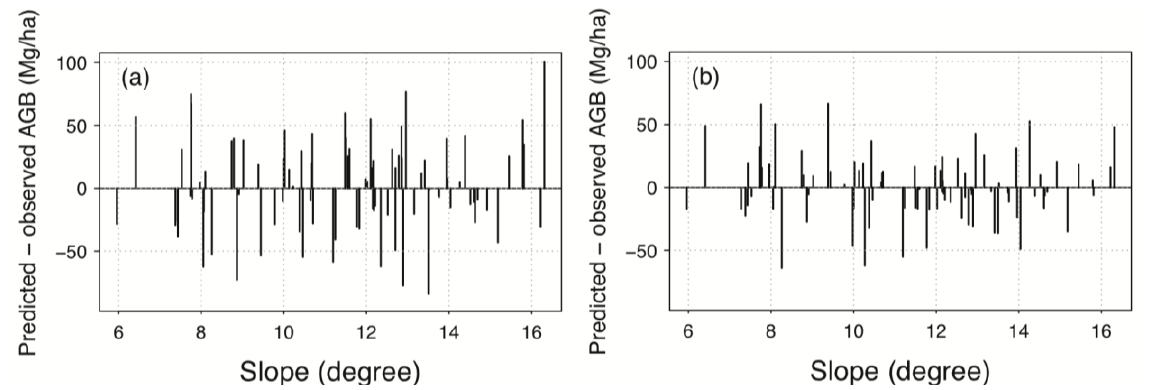
Figure 7. Distribution of difference between predicted and observed forest AGB values versus slopes of each plot ( a ) before ( b ) and after topographic